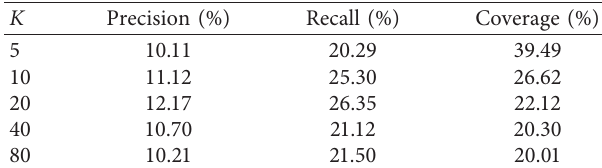
Table 4: User collaborative filtering under different K values based on the trust relationship by the communication